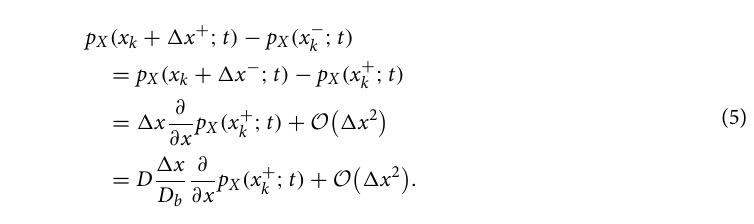
Figure 3. Exemplary simulated trajectory for κ located according to the standard Poisson random